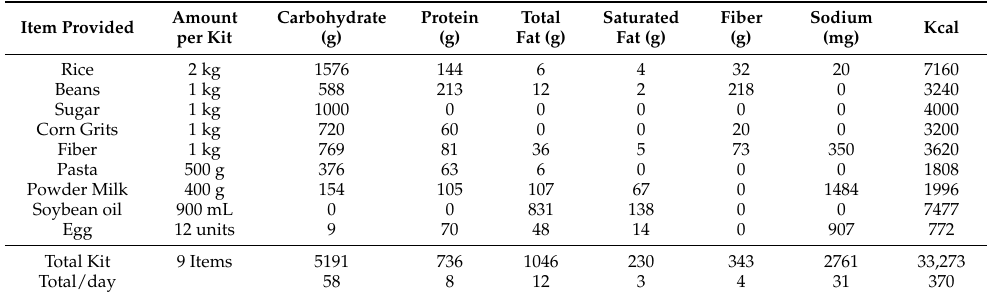
Table 1. Products included in the food